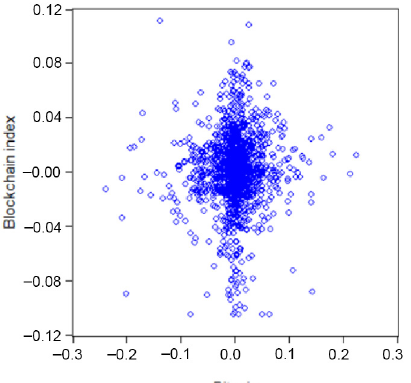
Figure 7. Scatter plot of bitcoin and the blockchain index closing price